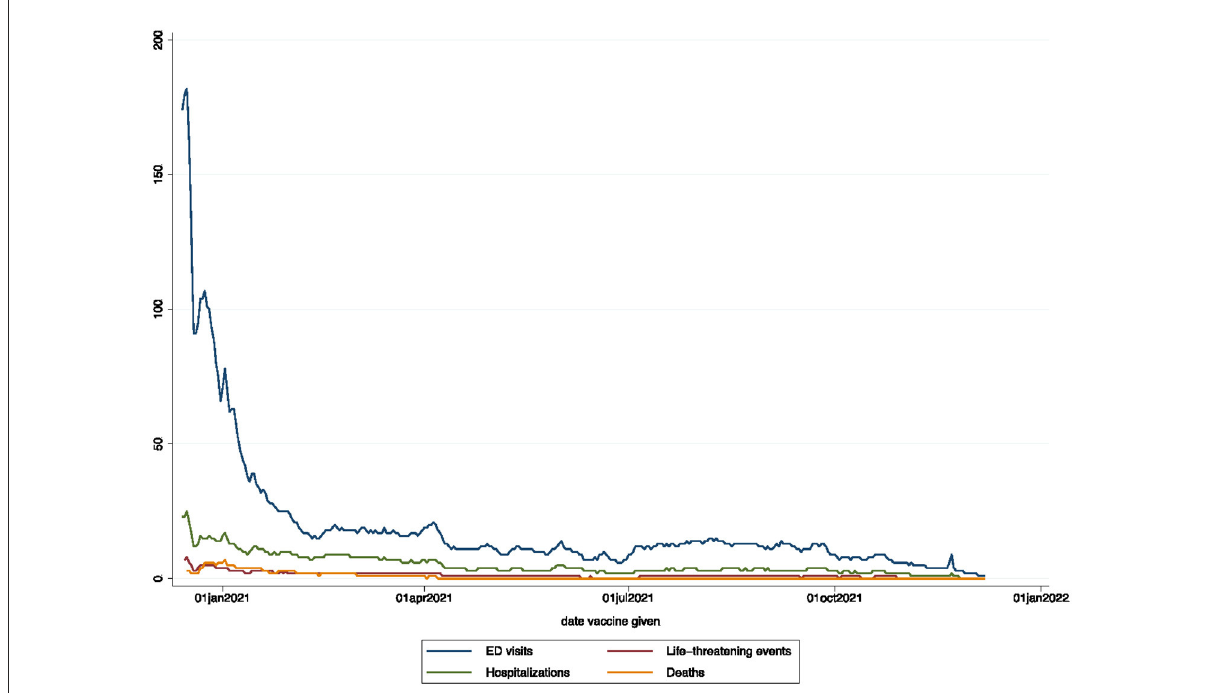
FIGURE1 Temporal reporting rates for outcomes (7-day moving average per 100,000